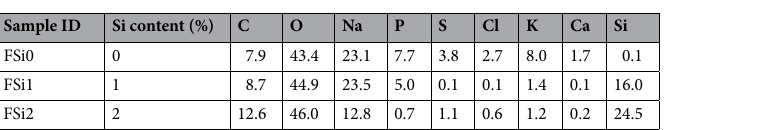
Table 6. The weight ratio of the main elements in residual